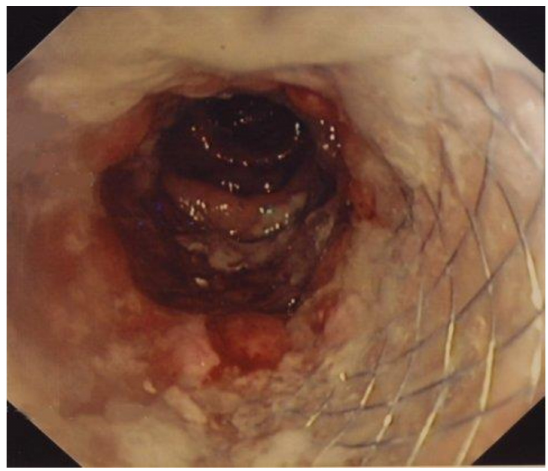
Figure 2. Colonoscopy showing the correct placement of the